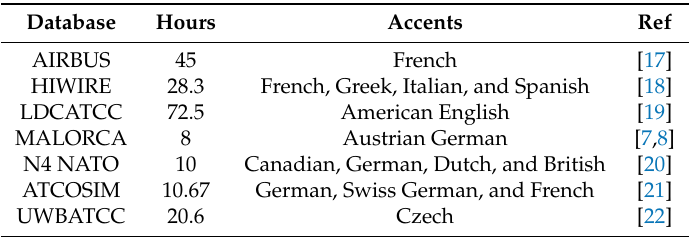
Table 1. Databases used for the speech recognition